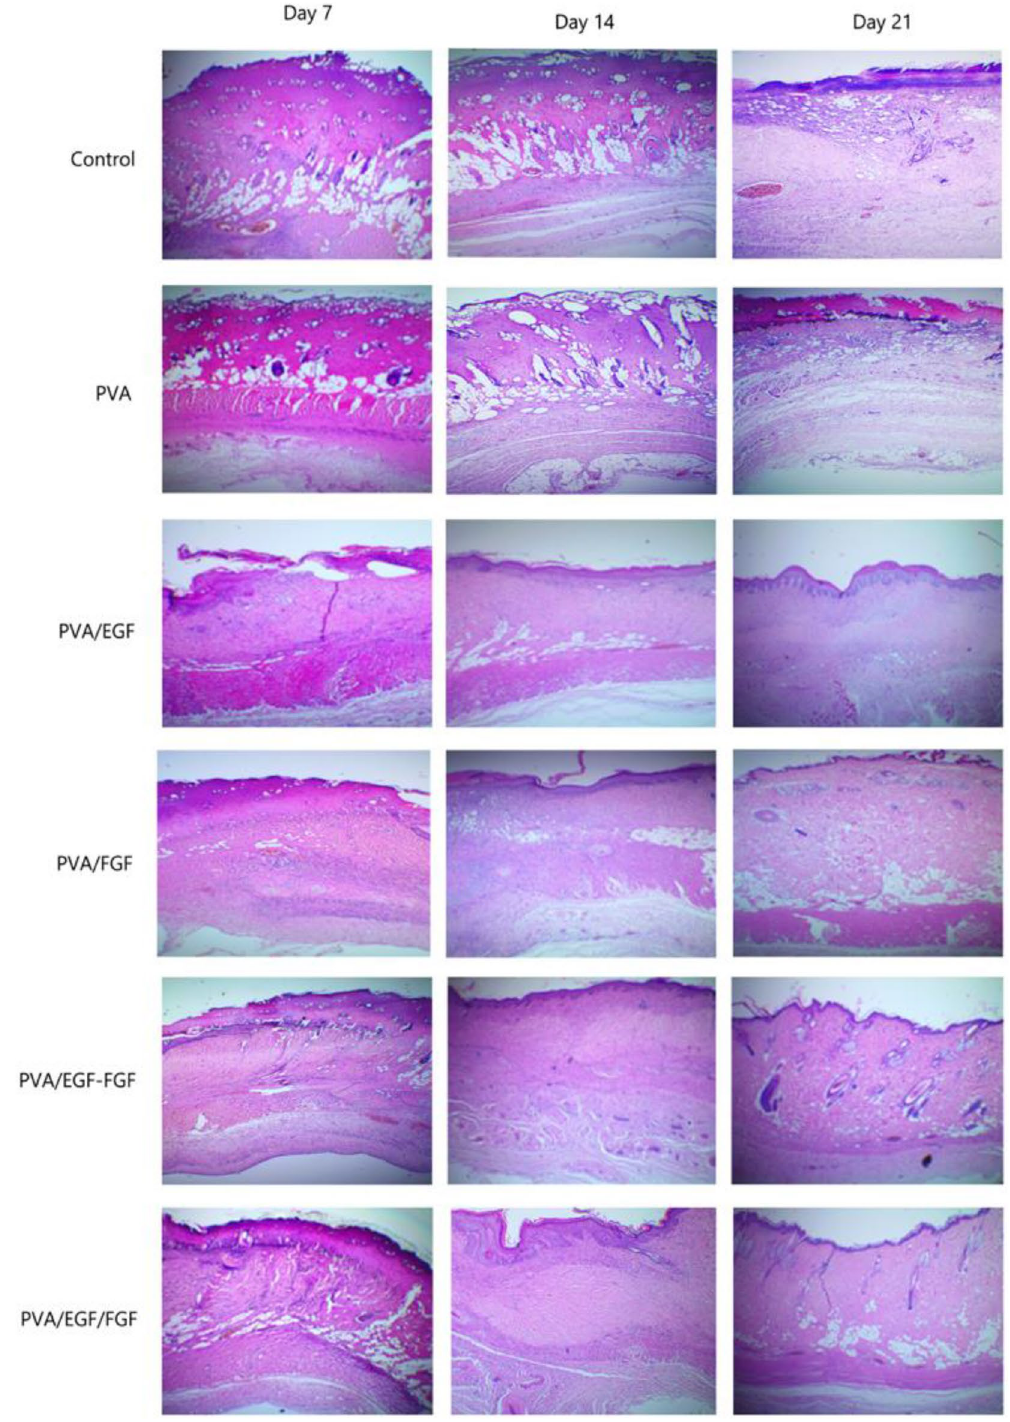
Figure 11. Histological sections of full thickness burn wound treated with various nanofibers (×40